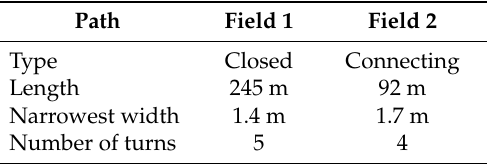
Table 3. Basic Attributes of the Table 3. Basic Attributes of the Fields. Table 3. Basic Attributes of the Fields. Table 3. Basic Attributes of the Fields. Table 3. Basic Attributes of the Fields. Table 3. Basic Attributes of the Fields.